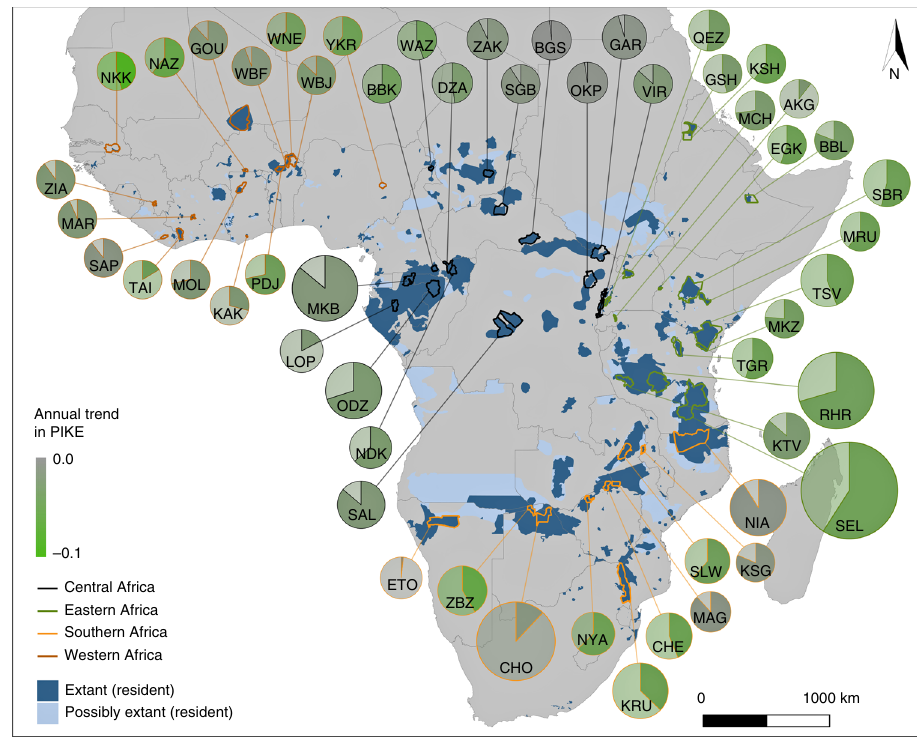
Fig. 1 Annual poaching trend by site. Map of MIKE sites 62 in Africa 76 , showing estimated elephant population sizes 15 (from <10 in Niokolo-Koba National Park, NKK, to 45,254 in Selous-Mikumi Game Reserve and National Park, SEL) proportional to the size of the respective pie chart, estimated median proportion of illegally killed elephants (illegal = solid pie piece, legal = transparent colours), annual trend in estimated PIKE (green = decline [ ^ ¼ less poaching], grey = no decline) between 2012 and 2017 (for site names see Supplementary Results), and the known and possible range of African savannah